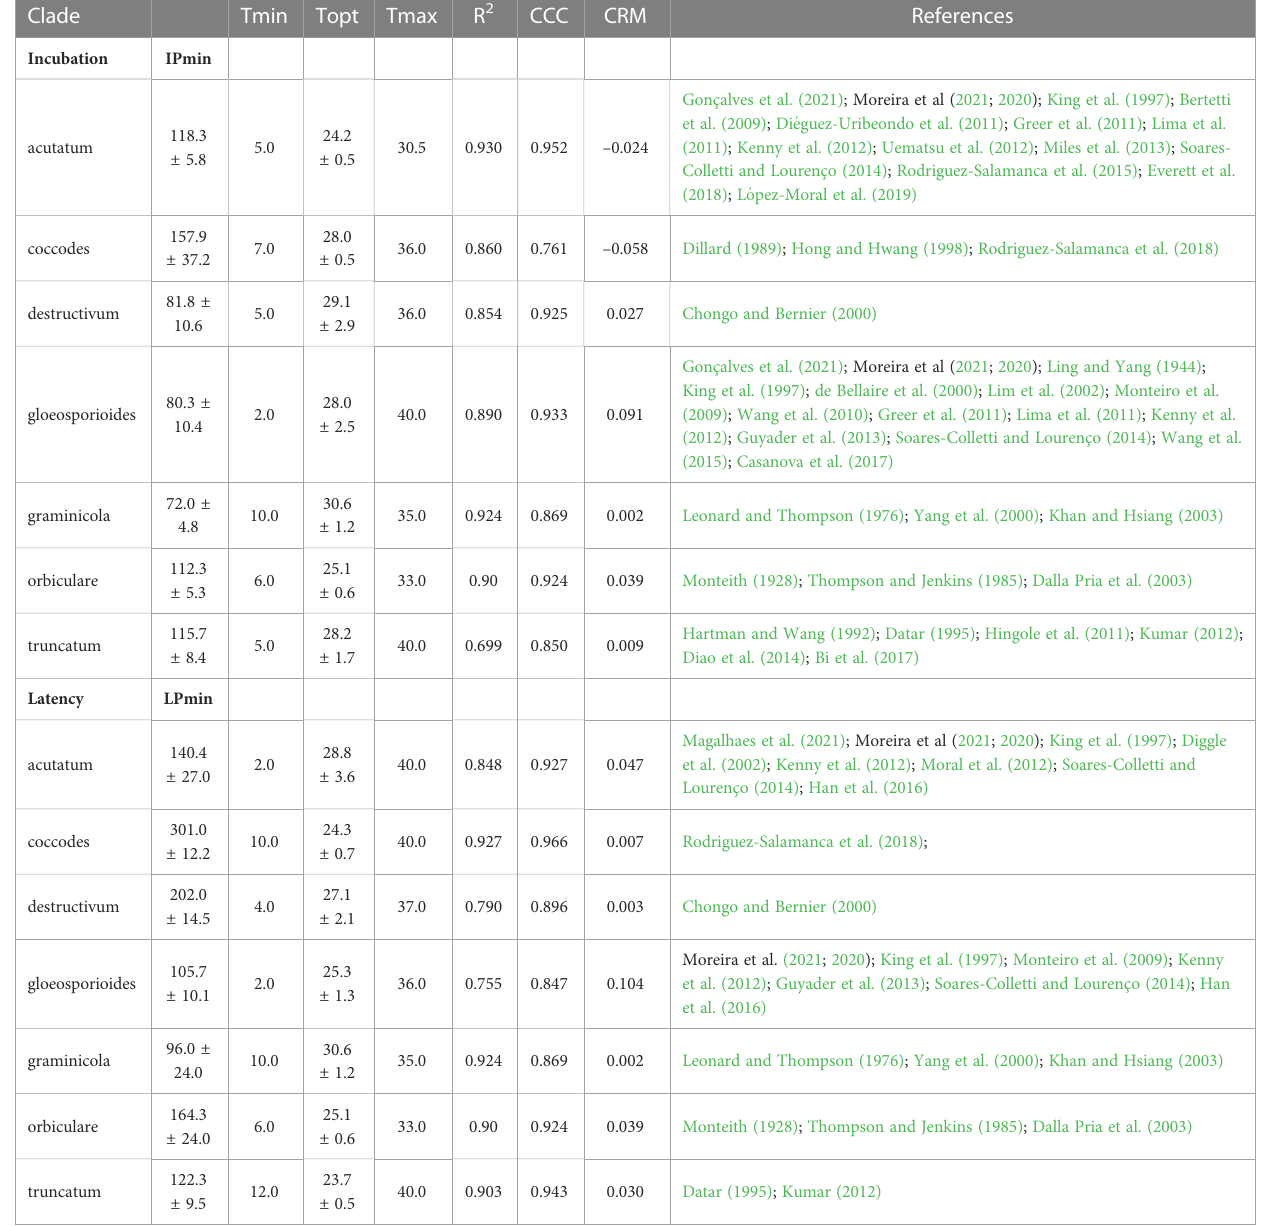
TABLE 4 Cardinal temperatures, estimates of the optimum temperatures with their standard error, estimates of the shortest duration of incubation (IPmin) and latency (LPmin) at optimum temperature with their standard error, and goodness-of- fi t of equation (16) for incubation and equation (17) for latency for each